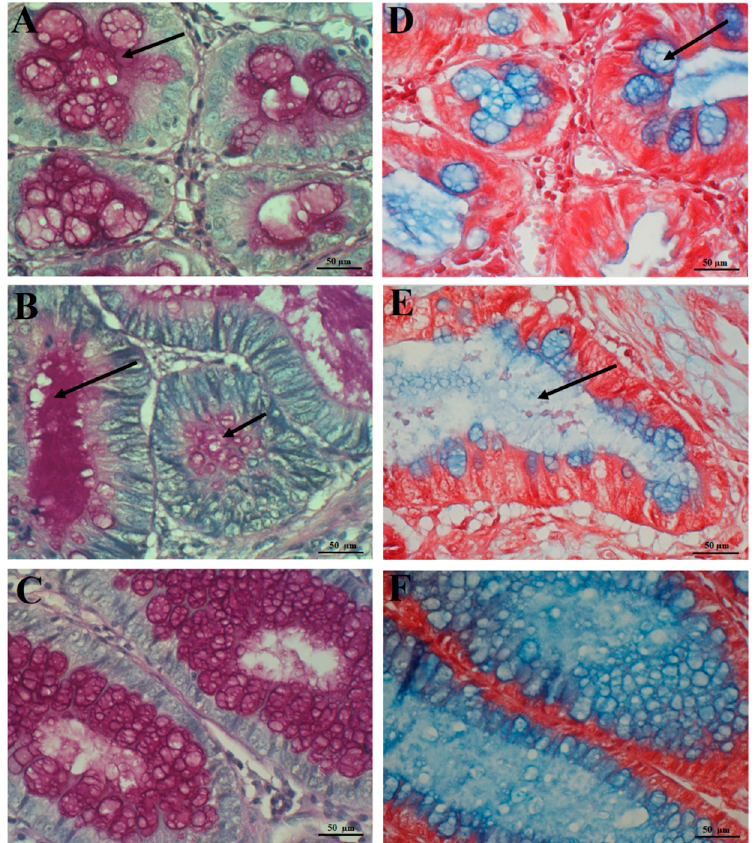
Figure 1. Illustrations with histochemical reaction in colorectal carcinoma ( A , B , D , E ) and normal colorectal tissue (control) ( C,F ). PAS reactivity in cytoplasm of the majority of neoplastic cells (arrow) ( A ); an intense PAS + reaction in the extracellular mucus produced by neoplastic cells (arrow) ( B ); representative image of PAS expression in the control intestinal crypts ( C ); light blue AB staining in neoplastic cells (arrow) and in the extracellular mucus (arrow) of colorectal carcinoma specimens ( D , E ); dark blue AB staining in goblet cells and in the lumen of normal intestinal crypts ( F ). Hematoxylin ( A , B , C ) and safranin ( D , E , F ) counterstained.